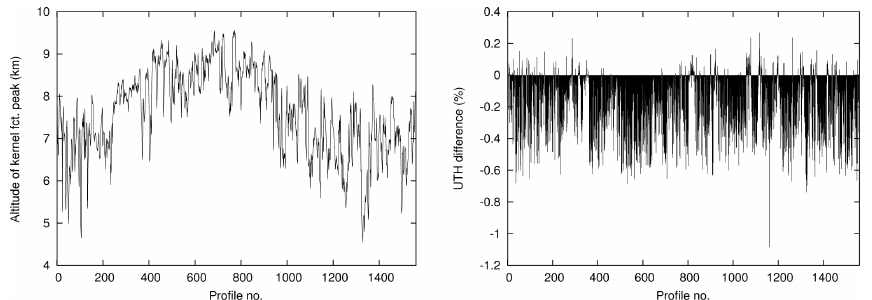
Figure 6. Left panel: peak emission altitude (kilometres) at Lindenberg for 1560 radiosonde profiles from February 2000 to April 2001. Right panel: UTH differences for changes in the peak emission altitude and water vapour scale height. Peak emission altitude is assumed to rise by 50m, scale height by